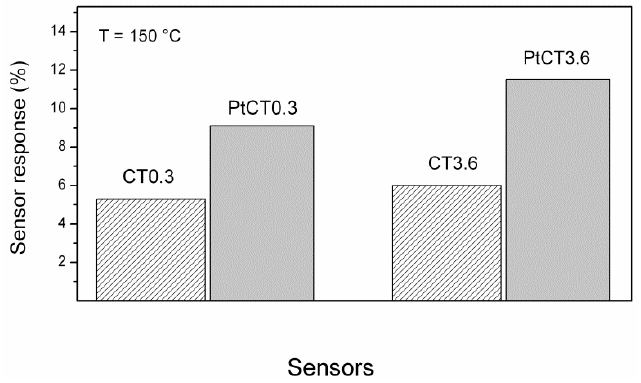
Figure 6. Comparison of the response of composite sensors with different C/Ti ratios and Pt loading to pulses of 0.5% of H in air of the duration of 250 seconds. 2